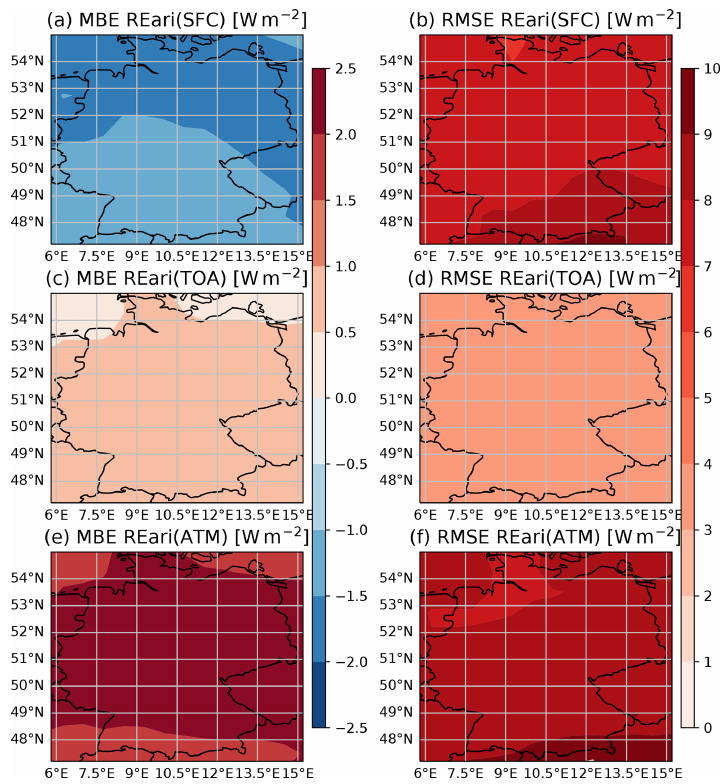
Figure D2. Annual mean of REari MBE and RMSE of T–CARS over the region of Germany. The RMSE is calculated for daily average values of REari at the surface (SFC), top of the atmosphere (TOA) and for the total atmosphere (ATM).